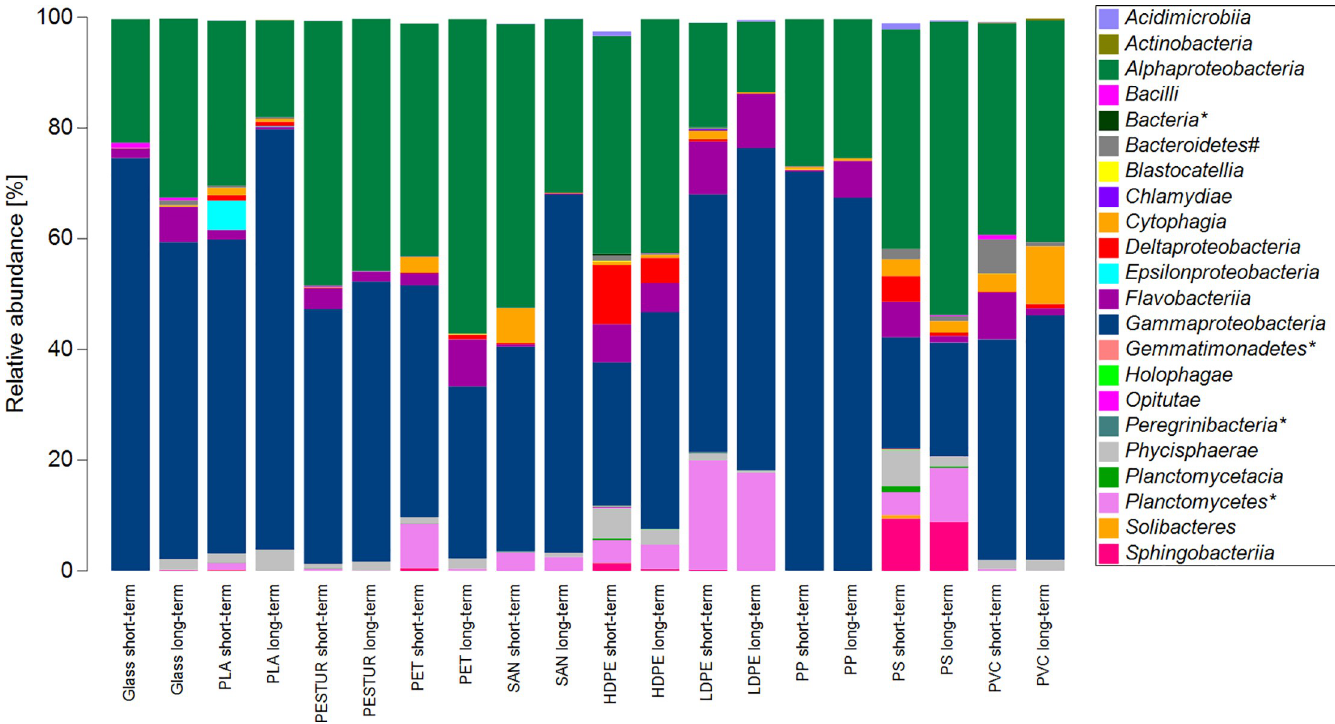
Fig 6. Biofilm community composition based on abundance profiles of the short- and long-term communities on the class level on different plastics and glass. OTUs with a mean relative abundance of at least 0.1% in one substrate type (n short = 1; n long = 5) were analysed. A � indicates the term “unclassified”, a # indicates the term “ Incertae Sedis